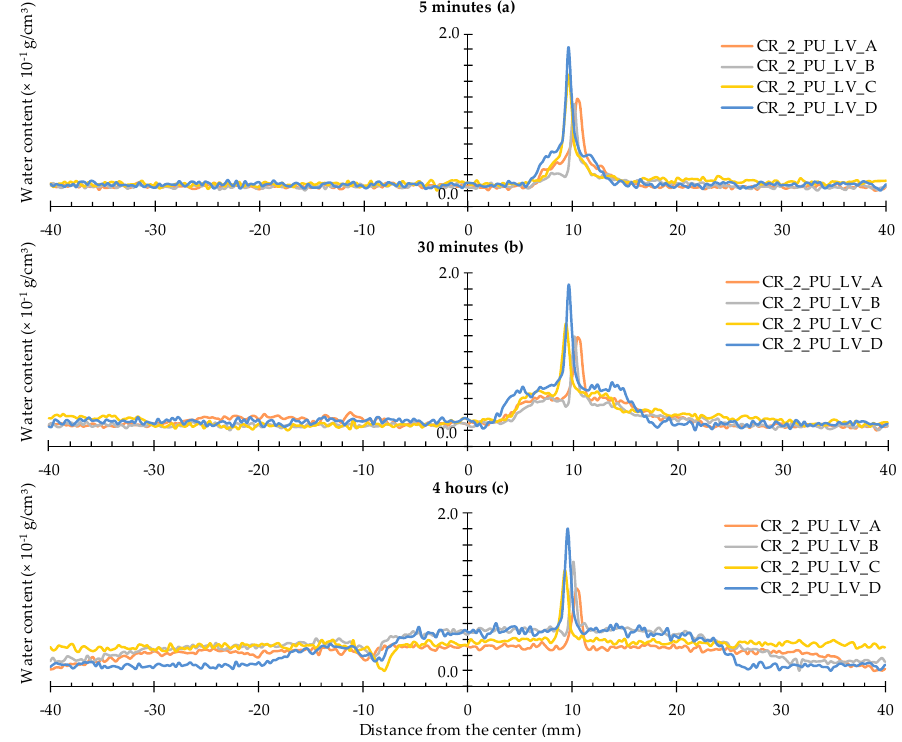
Figure 15. Water profiles of the four standard mortar prisms containing two artificial cracks healed with PU_LV: ( a ) after 5 min; ( b ) after 30 min; and ( c ) after 4 h.